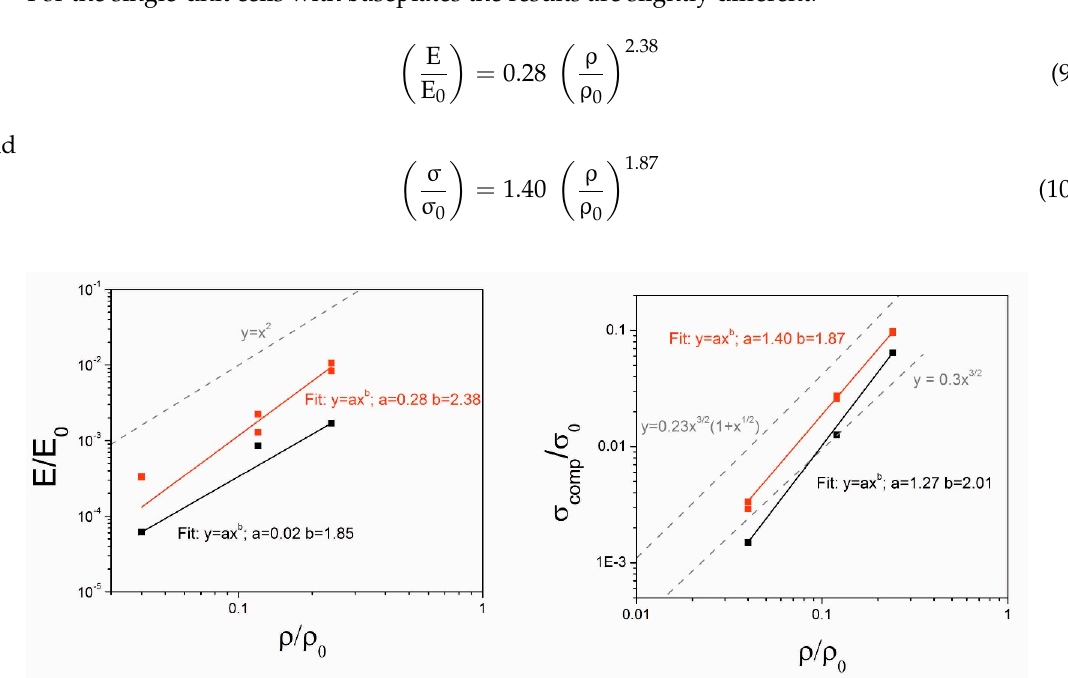
Figure 11. Specific properties of the rhombi-dodecahedron single-unit cell (black curves) and the single-unit cell with base plates (red curves); the value for E 0 is 210 GPa and for σ 0 200 MPa; fit functions have a 99.9% or higher probability; the grey dotted lines are values from the literature.